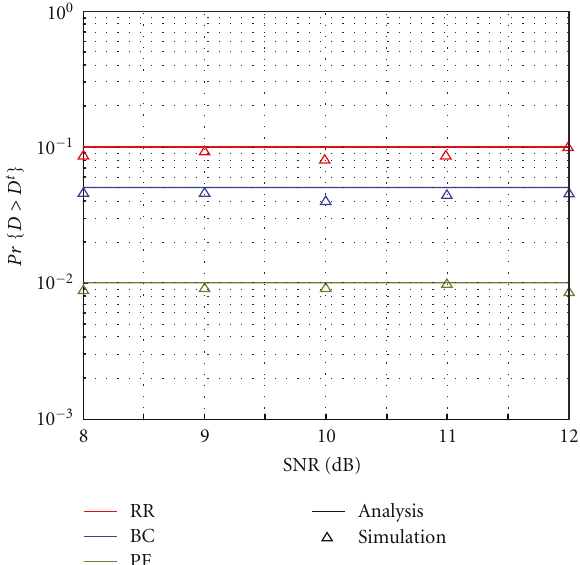
Figure 9: Simulation comparison for uncorrelated channel. 5 users = 8,9,10,11,12 dB, respectively. D t = 60 symbols. ε = 0 . 10 with γ u (RR), 0 . 05 (BC) and 0 . 01